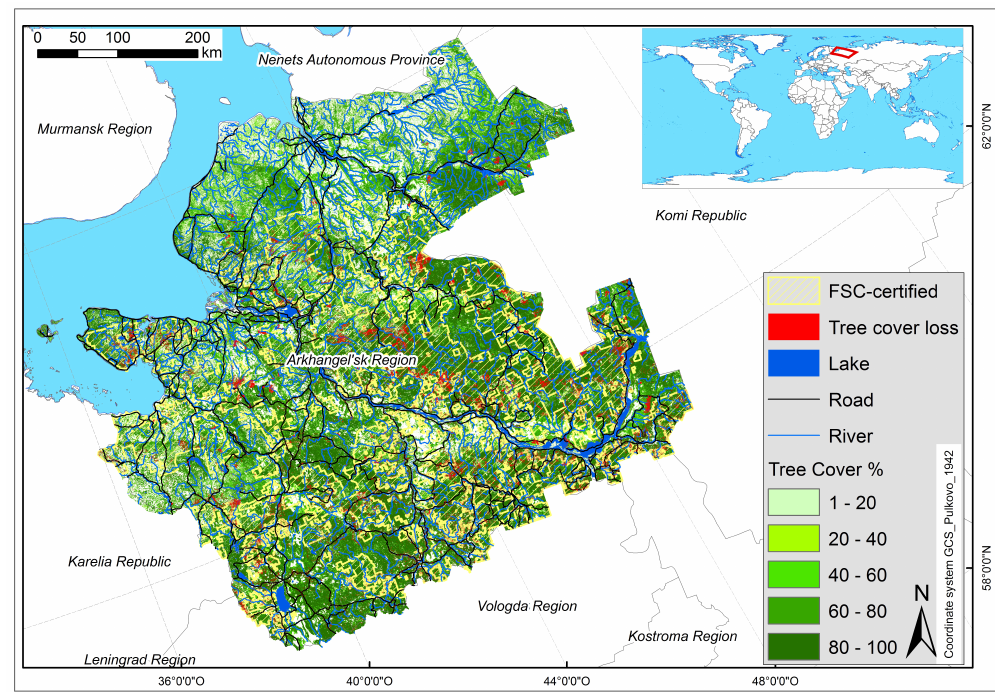
Figure 3. Map showing the Arkhangelsk Region and tree cover as of 2000 and tree cover loss between 2000 and 2014 [50], FSC-certified areas [51], and the network of lakes, rivers, and roads [55].